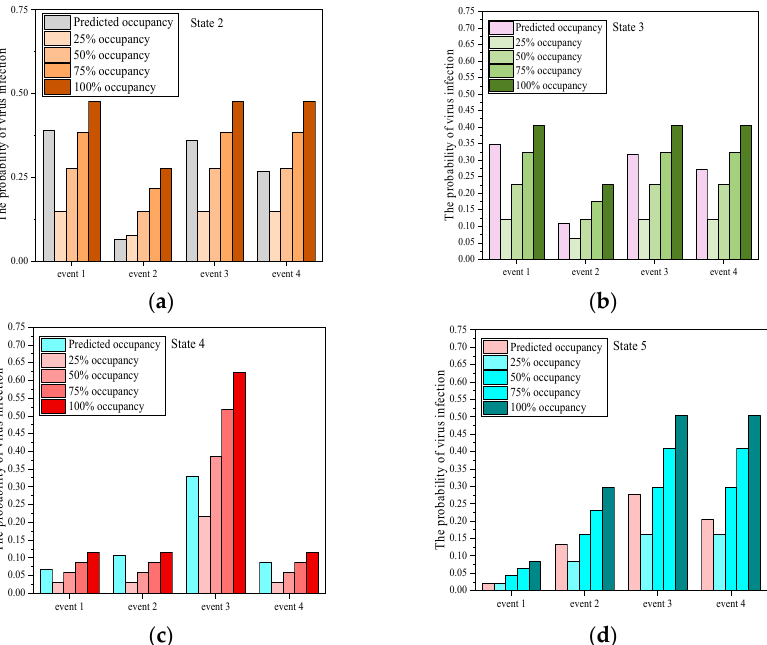
Figure 8. Influence of the occupancy constraints on the risk of virus infection. ( a ) Lecture building, ( b ) Office building, ( c ) Canteen building, ( d ) Library building. The effect of restricting occupancy on the decrease of infection risk will be more ob- vious with a greater predicted occupancy. Additionally, the effect of continuing to re- strict occupancy rate will be weakened when the predicted occupancy rate is reduced lower than 25%. Based on the results of the effect of building ventilation intervention and occupancy constraint on reducing infection risk obtained in Section 4.2.2 (1) and (2), the quantitative effect of increasing the ventilation rate and restricting occupancy is compared in Table 5. Table 5. Comparison of quantitative effect of the two measures on the risk reduction.